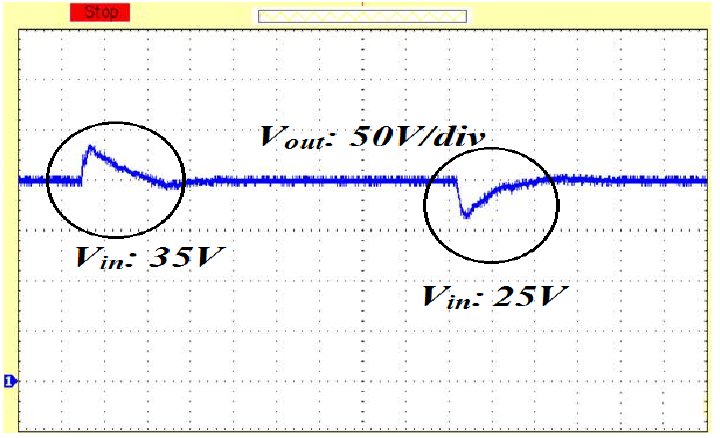
12 of 15 ( c ) Figure 11. Various waveforms: ( a ) V d1 and V d2 ; ( b ) V d3 and V d5 ; ( c ) V c1 and V out . As seen in Figure 11a, the voltage of the diode D 1 is less than 70 V, and the voltage across the diode D 2 is less than 30 V, and these voltages are the same as per Equation (5) and Equation (9). Figure 11b displays the voltage waveforms of V d3 and V d5 , and the values of these voltages are equal to 58 and 200 V, respectively, as per Equation (5) and Equation (10). The capacitor voltage, V c1 , waveform is illustrated in Figure 11c and equals less than 170 V. The proportional-integral (PI) controller verifies the dynamic response of the MQZS converter. The output voltage of the converter is sensed using the voltage sensor, LEM LV 25-P, and fed to the comparator to compare the actual voltage and converter’s reference voltage. The controller gain of the PI controller is chosen as K i = 0.01 and K p = 0.5 based on the trial-and-error method. The voltage control can control the output voltage at 200 V,